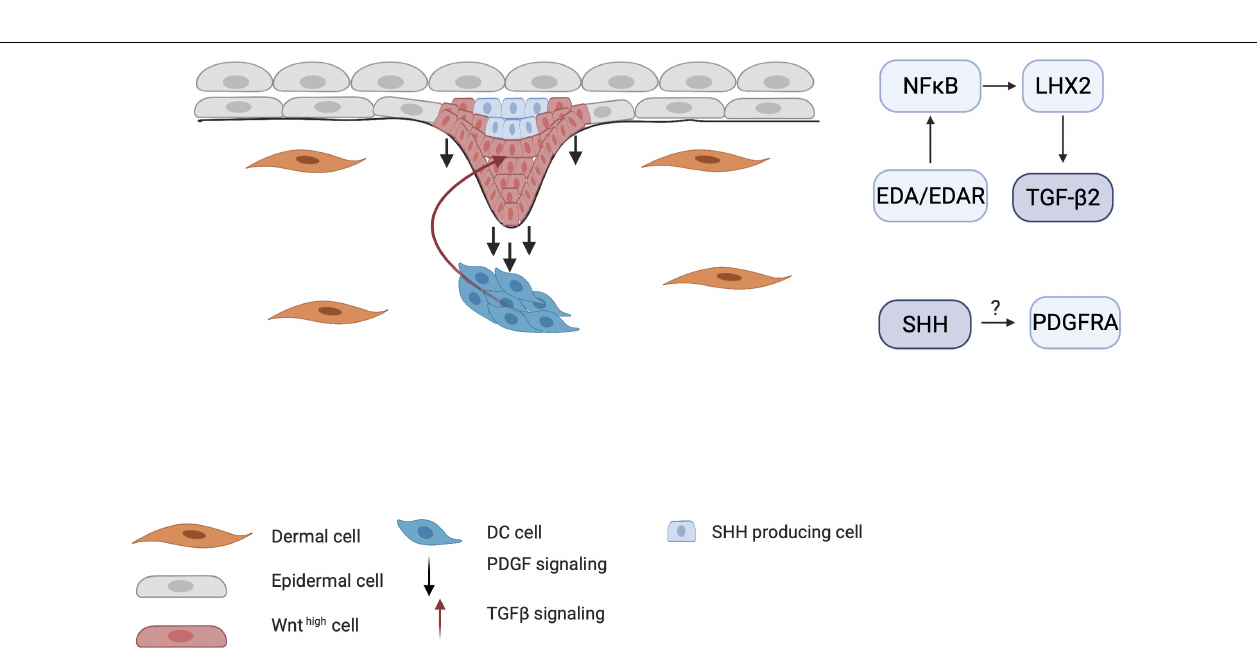
FIGURE 5 | Influence of Sonic hedgehog (SHH) on placode formation. SHH affects both the epithelial and mesenchymal layer of the developing hair follicle. SHH aids in the proliferation of the hair placode in the epithelial layer through cyclin D1. In the dermal condensate (DC), SHH primarily induces higher Noggin expression, creating a positive feedback loop for the downgrowth of the hair placode.